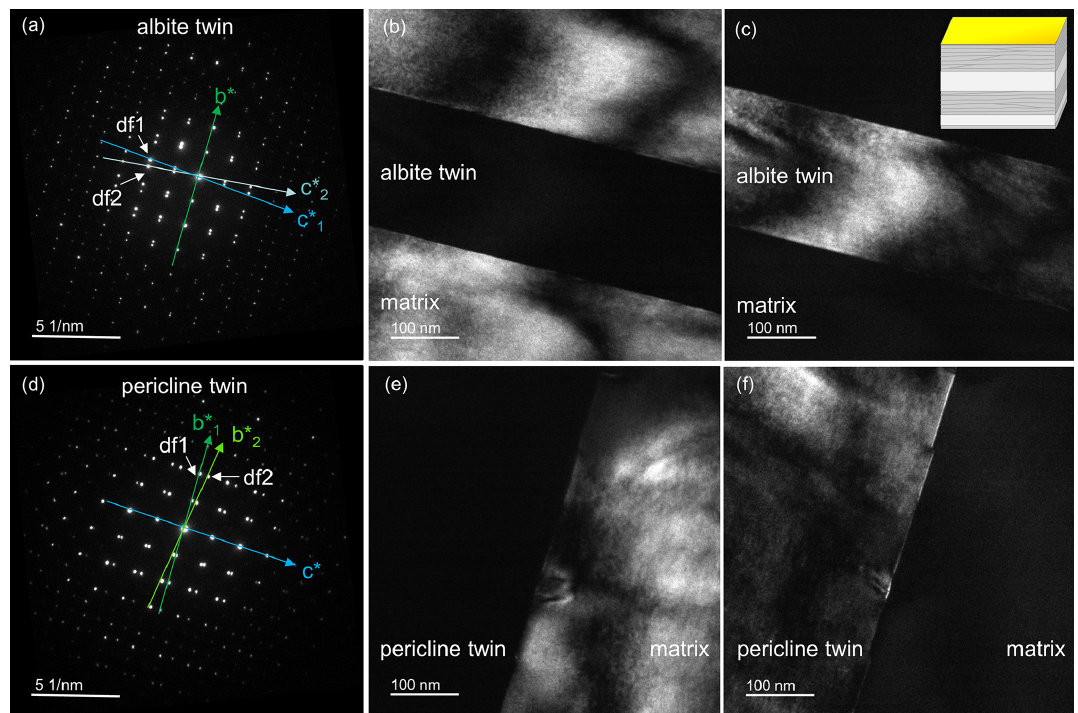
Figure 5. TEM images of twinning in labradorite. Panels (a) – (c) show the twin boundary of an albite twin, while (d) – (f) show the twin boundary of a pericline twin. (a) Diffraction pattern along the zone axis [100]. The splitting of the diffraction spots can be seen along c ∗ , resulting in c ∗ and c ∗ . (b) Dark-field image of df1, which lies in the direction c ∗ . The diffraction information arises from the matrix, while 1 2 1 in (c) , the dark-field image of df2 (lying on c ∗ ), only the albite twin is illuminated. (d) Diffraction pattern along the zone axis [100]. The 2 diffraction spots are split along the b ∗ axis, creating b ∗ and b ∗ . (e) Dark-field image of df1, which lies on the direction b ∗ 1 2 is illuminated, while in (f) , the dark-field image of df2, which lies on b ∗ , only the diffraction information from the pericline twin is shown. 2 Insert in the top-right corner of (c) was taken from Fig.